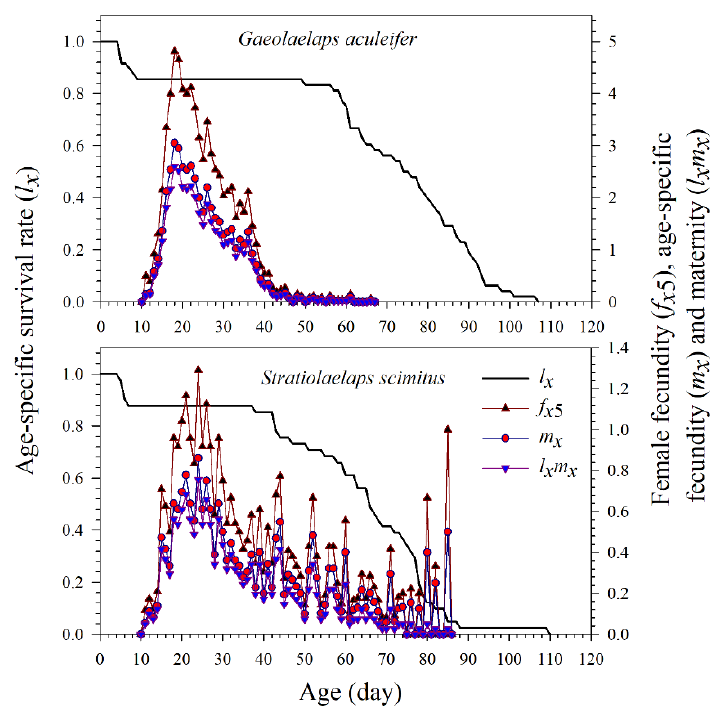
Figure 3. Age-specific survival rate ( l x ), female age-specific fecundity ( f x 5 ), age-specific fecundity ( m x ), and age-specific maternity ( l x m x ) of G. aculeifer and S. scimitus fed on T. putrescentiae. Life expectancy ( e xj ) indicates the length of time an individual of age x and stage j is expected to survive. The curves of e xj of the egg, larva, protonymph, deutonymph, and adult of G. aculeifer fed on T. putrescentiae were higher than those of S. scimitus (Figure 4). The life expectancy values of a newly-laid egg of G. aculeifer and S. scimitus were 67.33 and 60.34 d, respectively (Figure 4). Figure 4. Age-stage-specific life expectancy ( e xj ) of G. aculeifer and S. scimitus fed on T. putrescentiae.